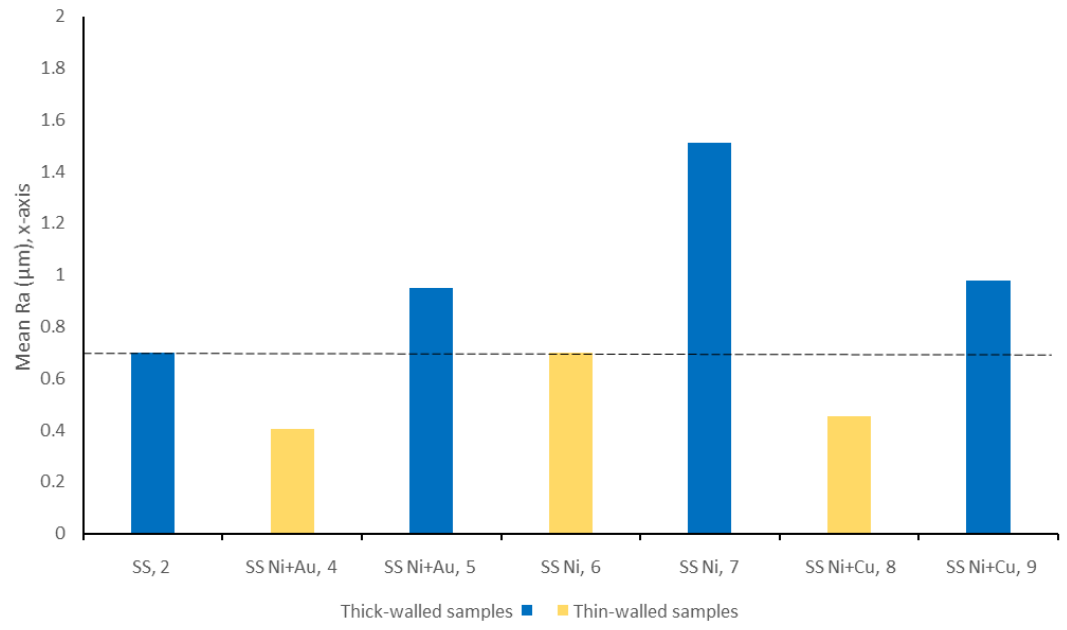
Figure 15. Surface roughness, Ra, values of the exterior surfaces of the coated samples compared to the uncoated samples.